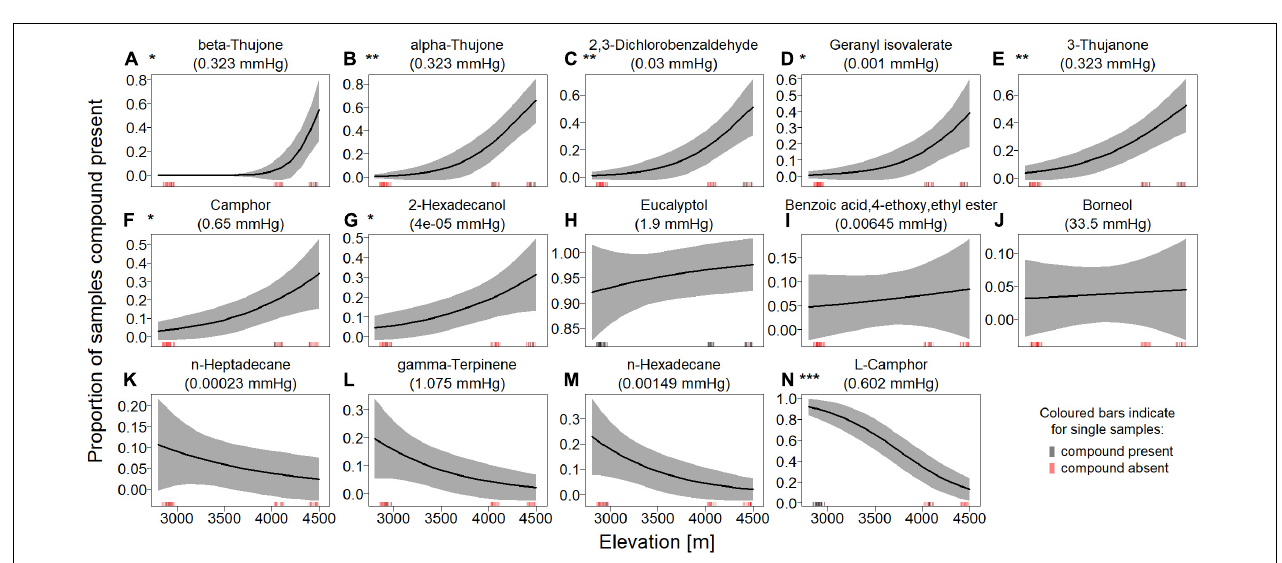
FIGURE 1 | Effect of elevation and vapor pressure on overall presence of volatile organic compounds (VOCs). (A) Effect of elevation on number of VOCs detected per sample. Solid lines show the estimated marginal means from the GLM and the gray-shaded area shows the 95% confidence interval. Raw data is displayed as dots ( n = 79), slightly jittered to avoid overlap. The significance of the effect is highlighted with common asterisk notation. (B) GLM estimates for the two-way interaction between elevation and vapor pressure on the probability that a compound was detected in a sample ( n = 79). One of the squares represents a combination of values of elevation and vapor pressure. The color of a square shows the magnitude of the estimated proportion, with yellow squares denoting higher proportions. The vapor pressure axis was logarithmized.